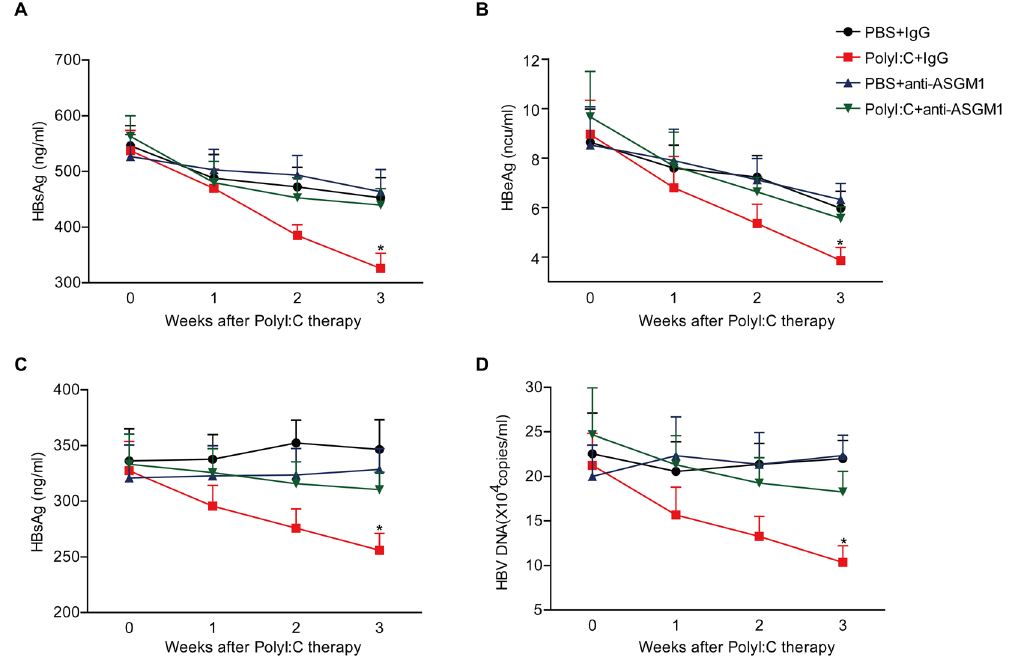
Figure 7. PolyI:C therapy leads to NK cell-dependent anti-HBV activity in HBV-tolerant mice and HBV- transgenic mice. ( A , B ) C57BL/6 mice were injected with HBV plasmid, 2 weeks later, HBV-tolerant mice were chronically treated with control Ab or anti–ASGM-1 Ab and Poly I:C, as described in Materials and Methods, for 3 weeks. Titers of serum HBsAg ( A ) and HBeAg ( B ) were determined at the indicated time points post injection. * p < 0.05 vs. PBS + IgG group or PBS + anti–ASGM1group or Poly I:C + anti–ASGM-1group. Data are shown as mean ± SEM; n = 5 in each group. ( C , D ) HBV-transgenic mice were chronically treated with control Ab or anti–ASGM-1 Ab and Poly I:C, as described in Materials and Methods, for 3 weeks. Titers of serum HBsAg ( C ) and HBV DNA ( D ) were determined at the indicated time points post injection. * p < 0.05 vs. PBS + IgG group or PBS + anti–ASGM1group or Poly I:C + anti–ASGM-1group. Data are shown as mean ± SEM; n = 3–5 in each